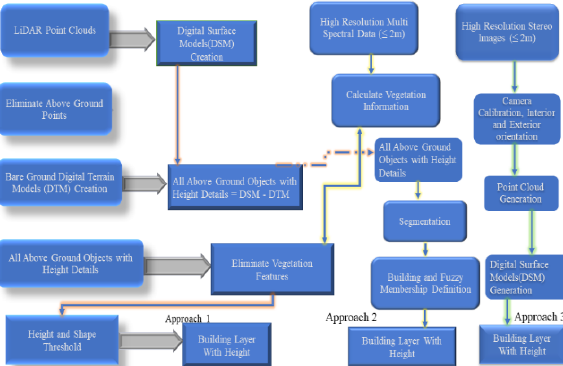
Figure 2. Extraction Process for structural health